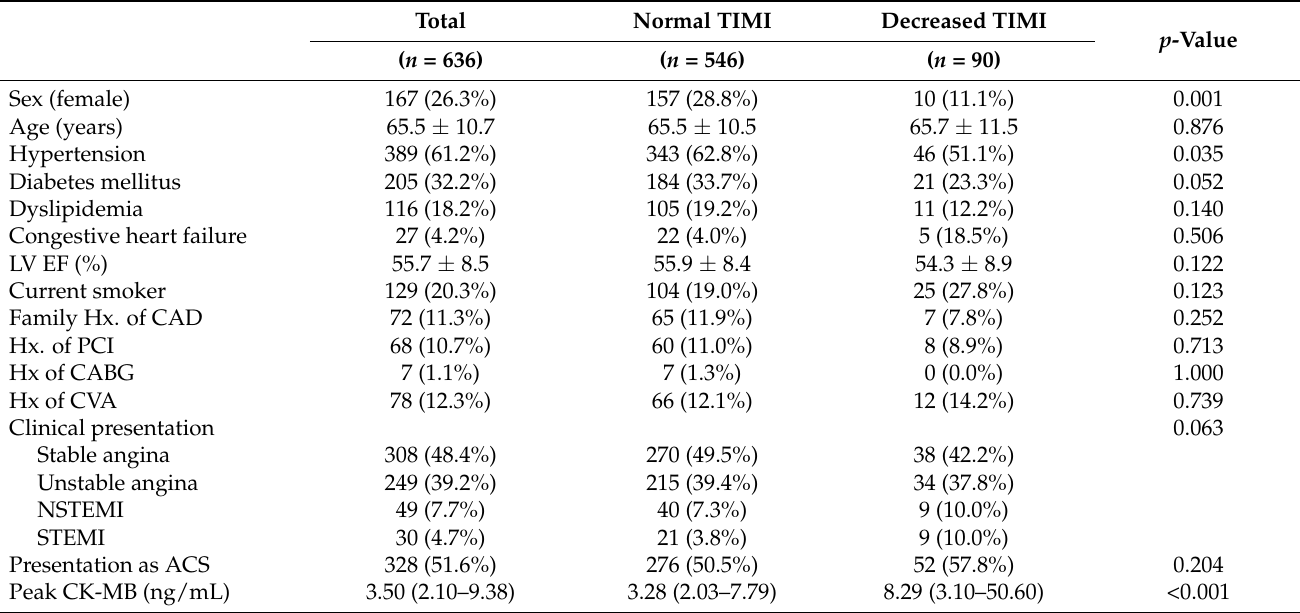
Table 1. Baseline clinical characteristics of the study population.